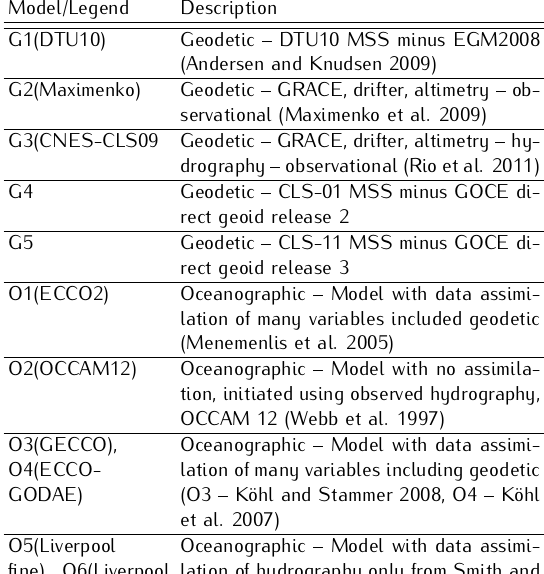
Table 1. Summary of SST Models Tested Model/Legend